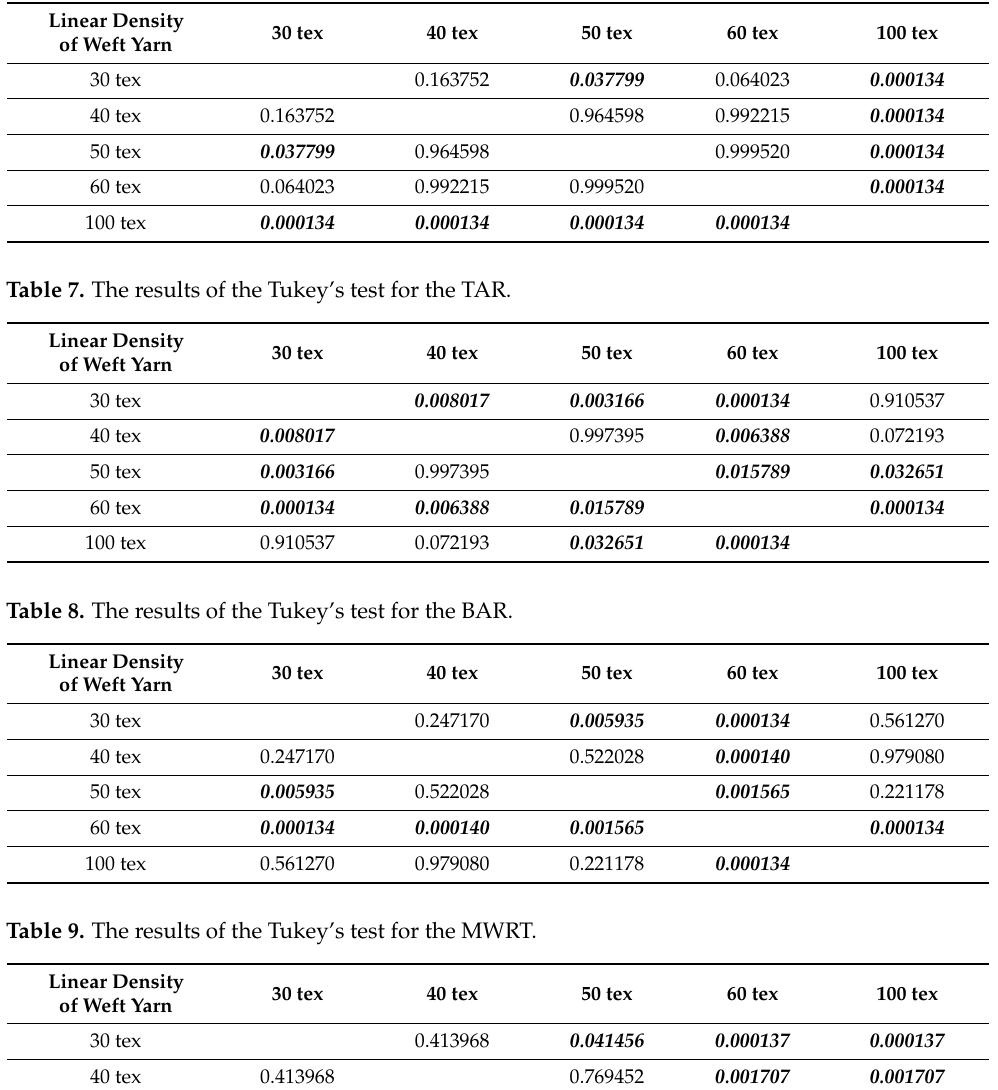
Table 6. The results of the Tukey’s test for the WTB.